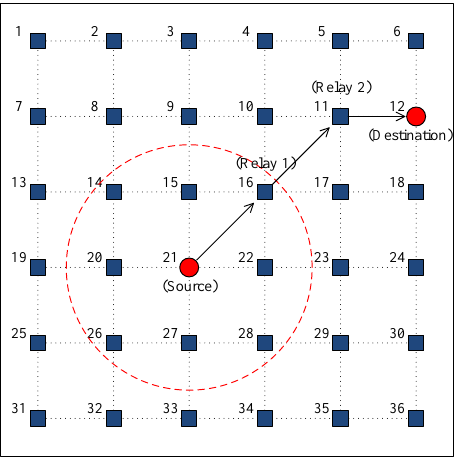
Figure 10. Network topology used in the simulations.